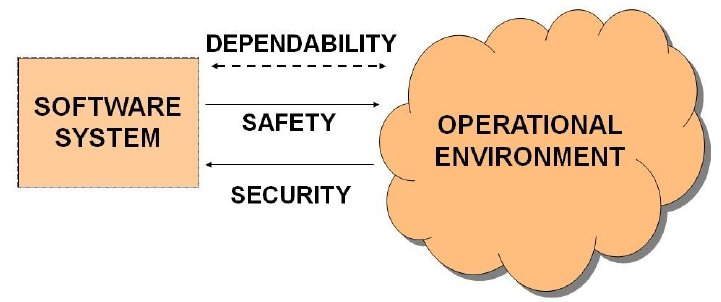
Figure 1. Relationship between safety and security with the environment.